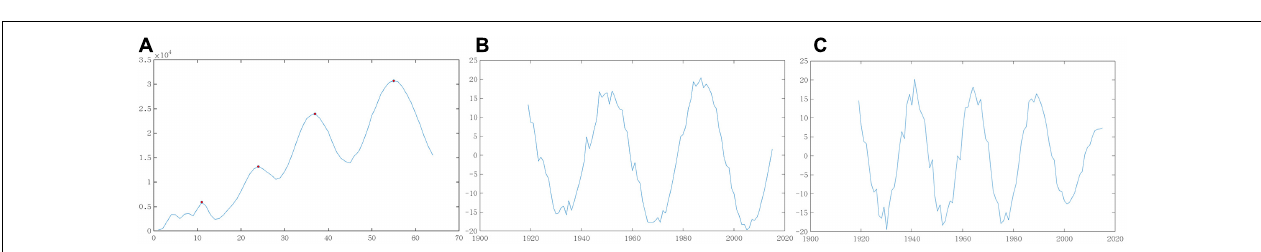
FIGURE 4 | Wavelet contour map with Morlet wavelet. (A) Modulus of wavelet coefficient. (B) Modulus square of wavelet coefficient.